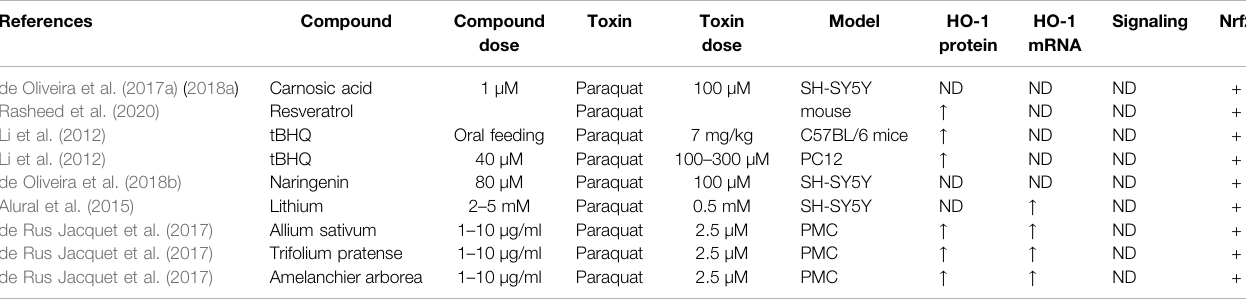
TABLE 10 | Summary of the experimental studies involving HO-1 inducer against paraquat-induced PD